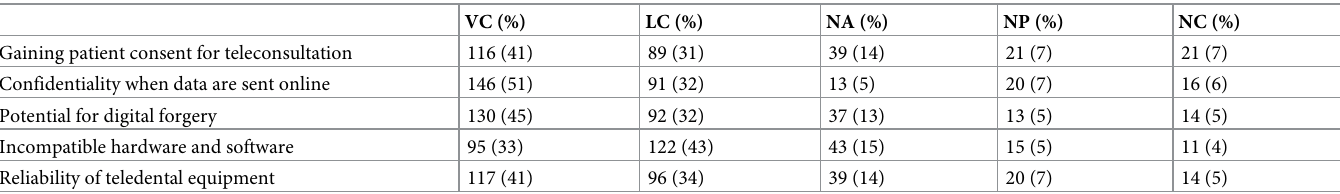
Table 2. Practitioners’ concern about data security and patient consent.